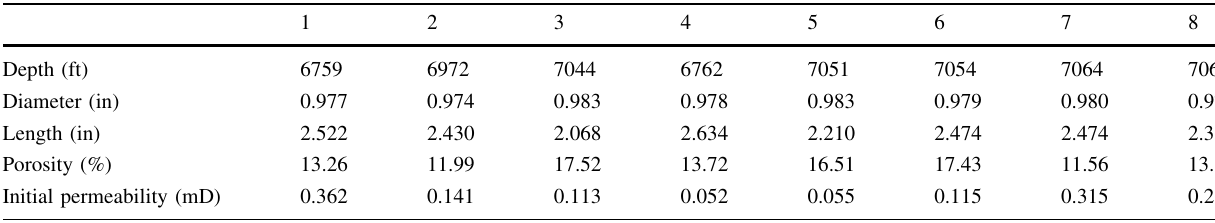
Table 1 Petrophysical characterizations of